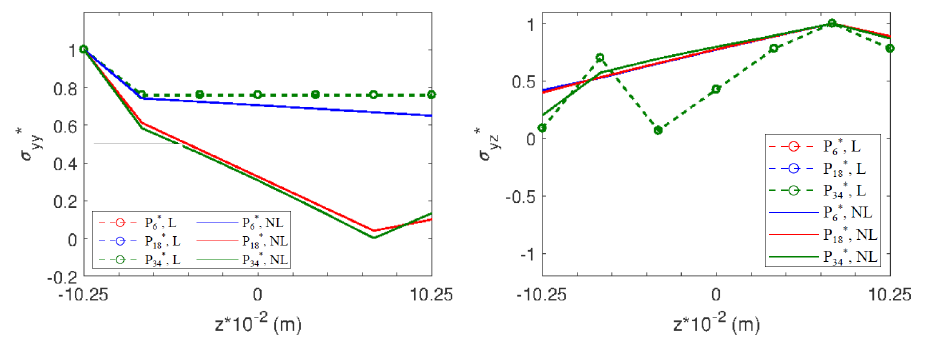
and σ ∗ yz = σ yz / σ yz . max max